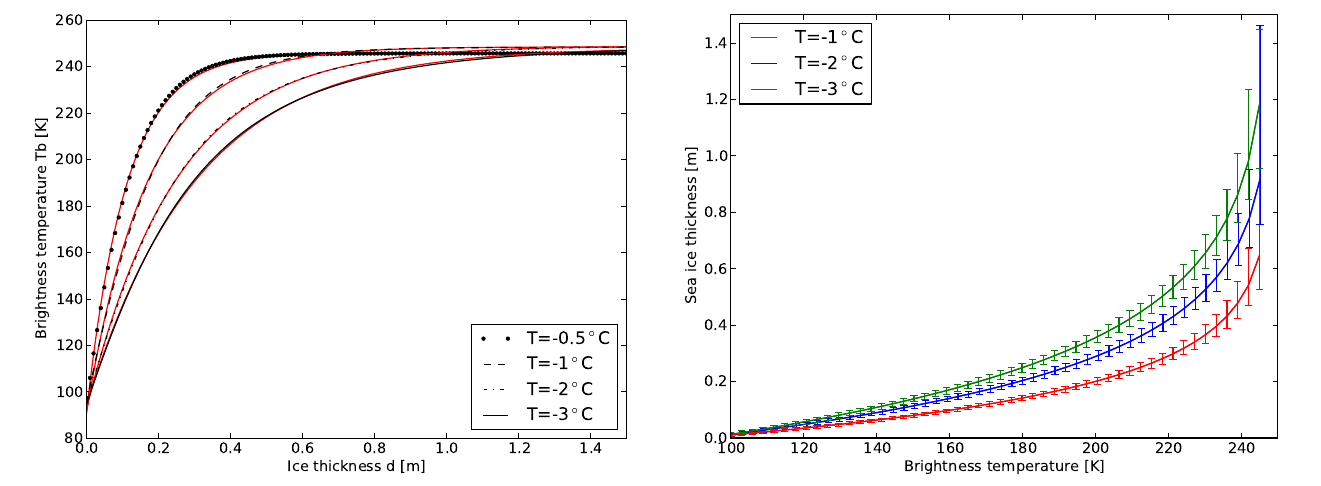
Fig. 3. Model inversion for the retrieval of the ice thickness from the brightness temperature. The error bars indicate ± 3.5K variations of the brightness temperature which corresponds to a 5% error of ice